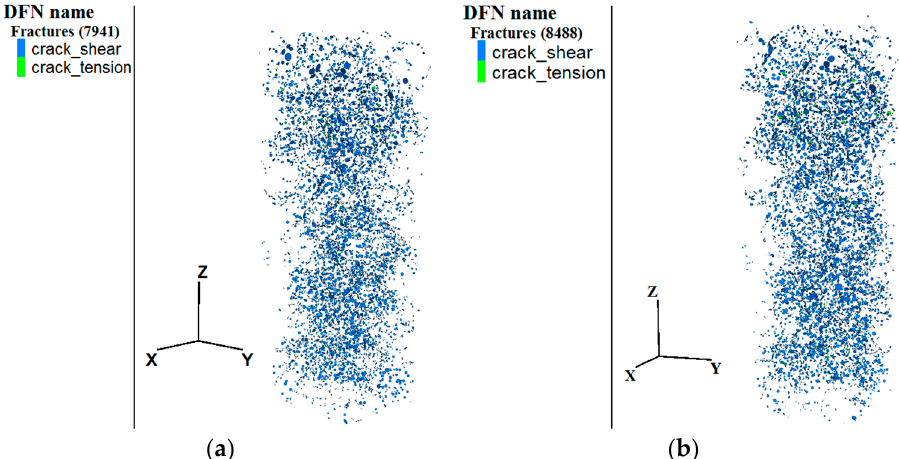
Figure 14. Number of concrete cracks at the second stage point with ( a ) 75 and ( b ) 150 freeze–thaw cycles.